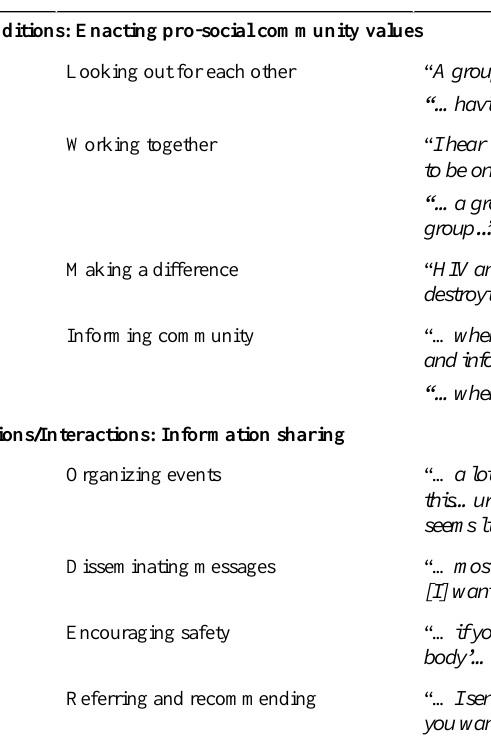
Sample participant